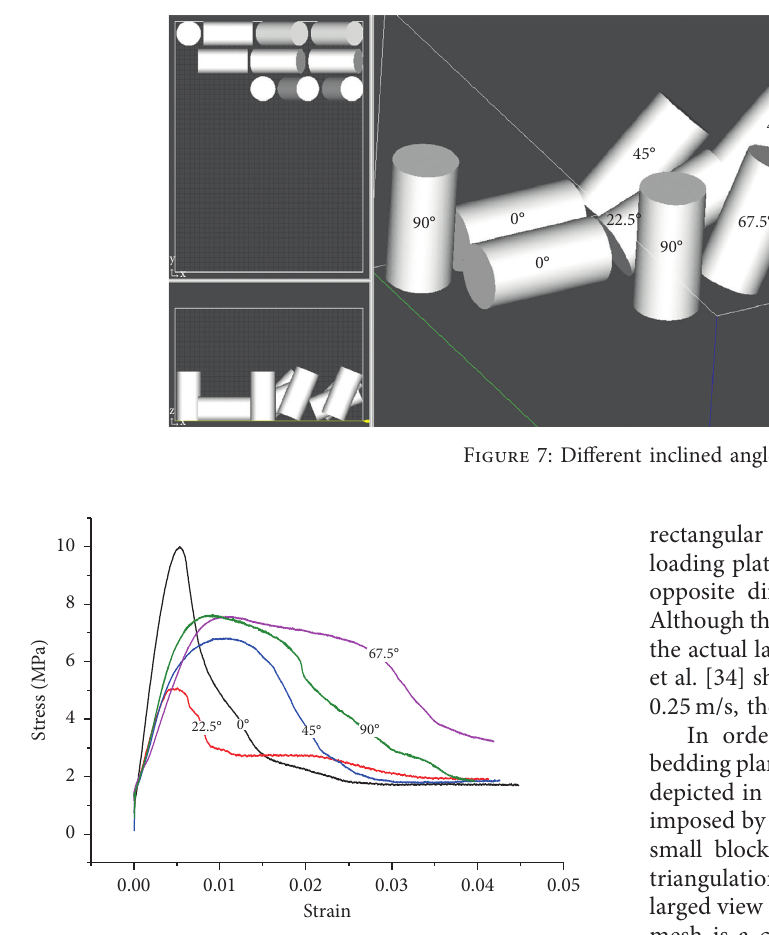
Figure 8: Stress-strain curves of 3D-printed samples in UCS tests under different inclined